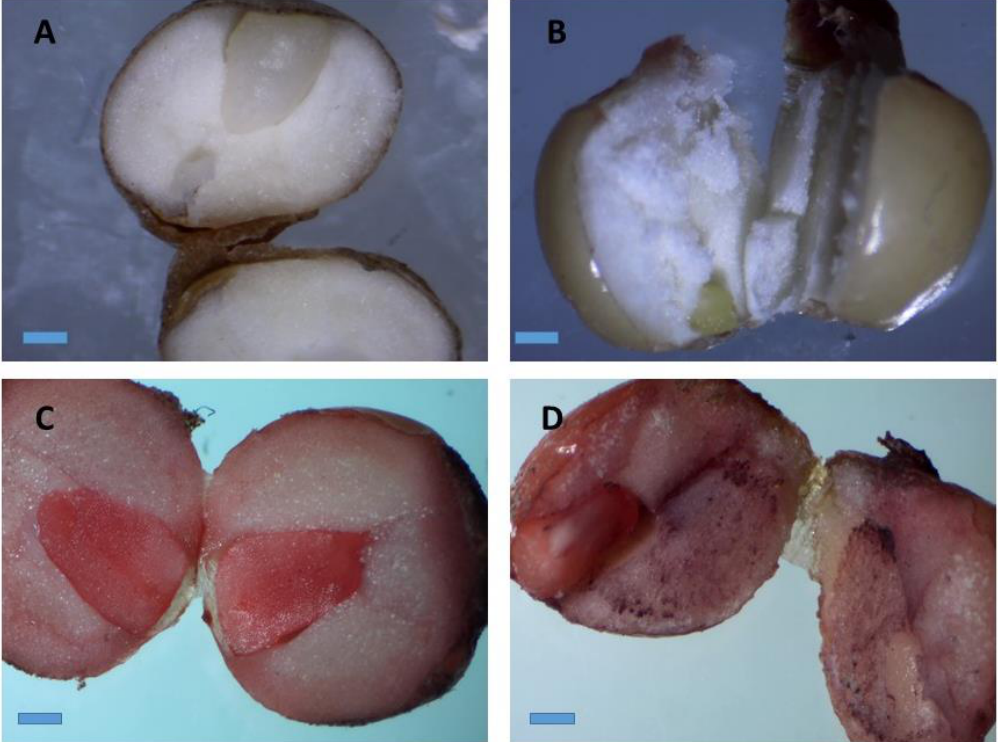
Figure 2. Stereo microscopic images of stained A. longiloba embryos by immersion in a tetrazolium solution. ( A ) Natural color of A. longiloba seed; ( B ) non-viable seed which retained its original color after TZ treatment; ( C ) and ( D ) red–pink color stained on the embryo after TZ treatment which indicates that the seed is viable (magnification: 40×; bar: 1 cm).